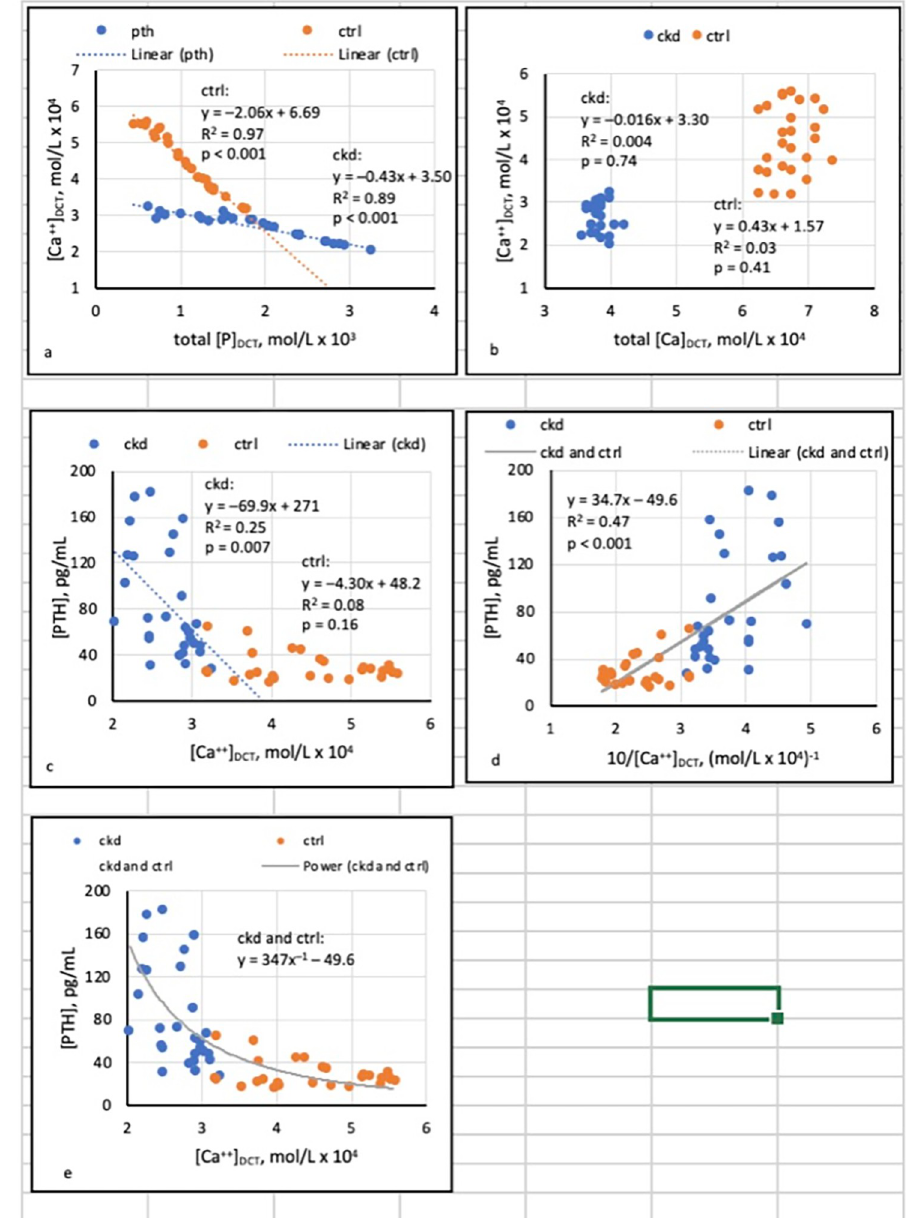
Fig 3. Regressions assuming pH 6.8 and precipitation of Ca 3 (PO 4 ) 2 (am.,